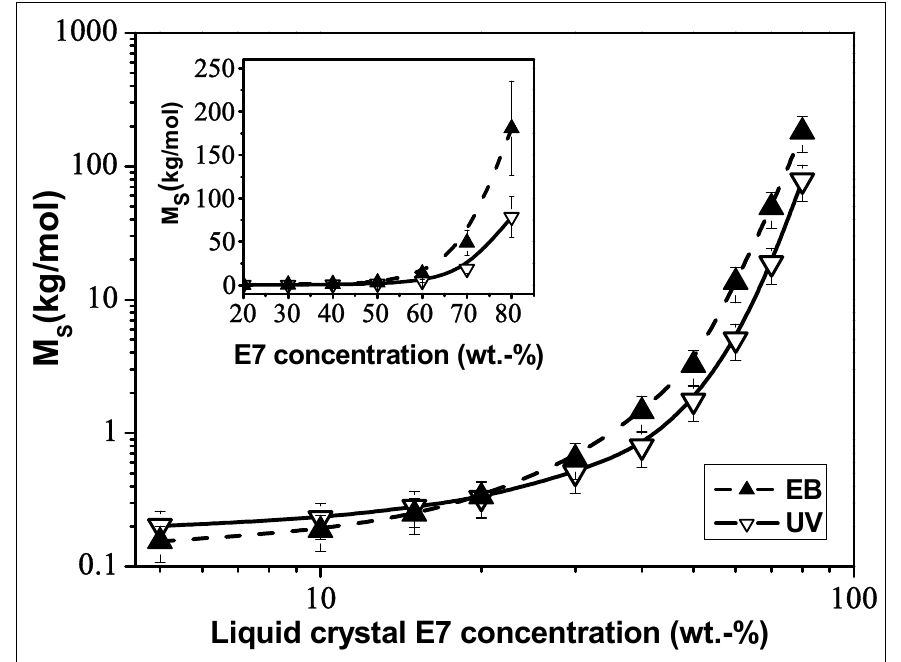
Figure 4. Molecular weight of strands ( M s ) between two adjacent cross-linking points of EB- and UV-cured TPGDA/E7 blends, as function of LC concentrations on a double logarithmic scaling. The inset shows the same results when applying a linear scaling.